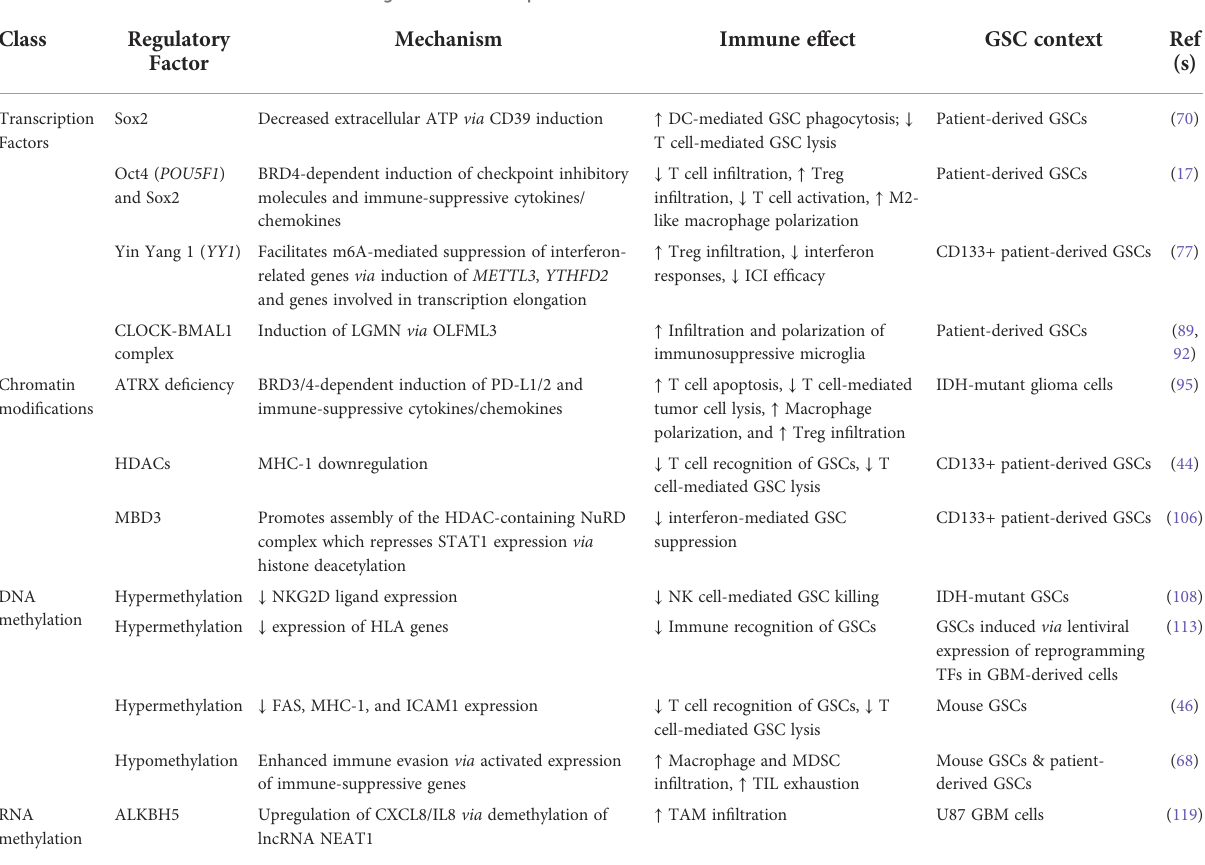
TABLE 1 GSC-intrinsic mechanisms modulating the immune